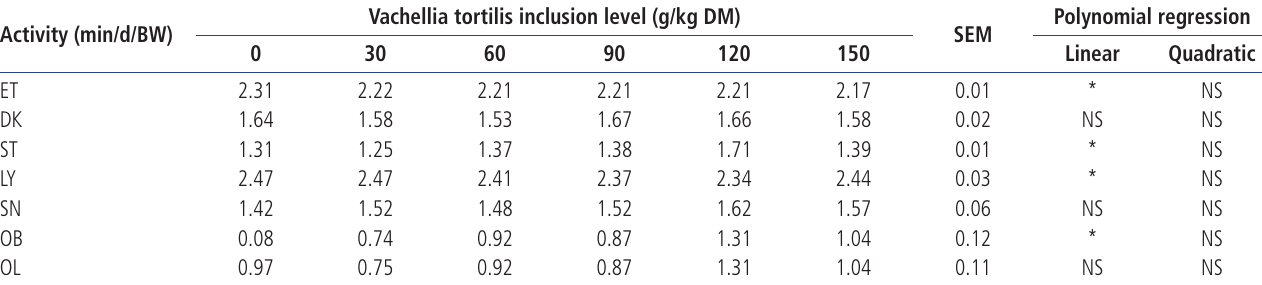
Table 6. Relationship between time spent on behavioral activities with increasing level of Vachellia tortilis leaf meal Vachellia tortilis inclusion level (g/kg Activity (min/d/BW)